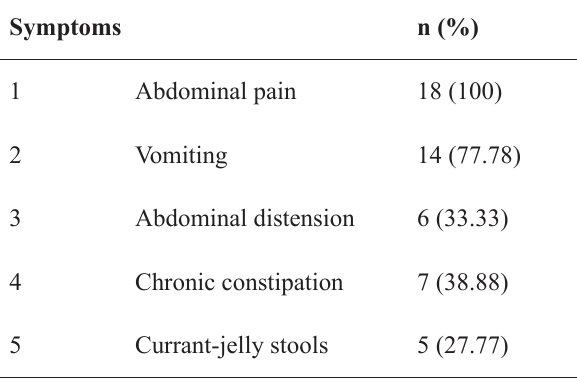
Table 1. Clinical presentation of adult intussusception Symptoms n